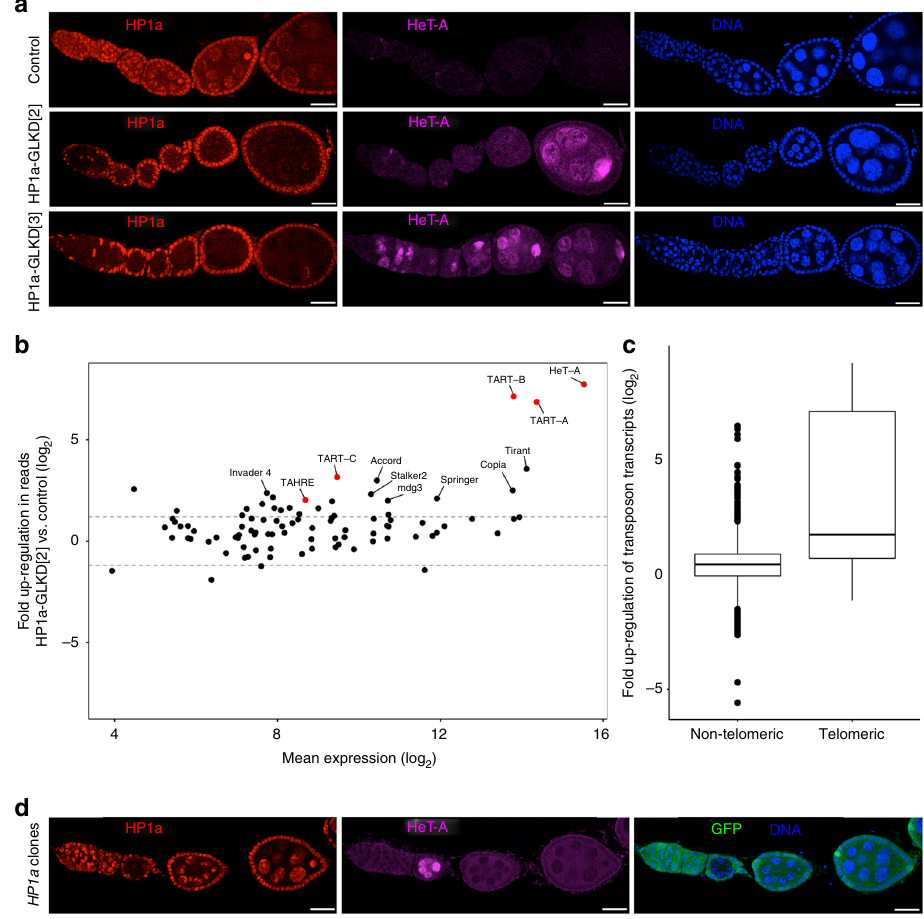
Fig. 1 HP1a is required for the repression of selective transposons. a Representative images showing control and HP1a-GLKD fl y ovaries stained for HP1a and HeT-A Gag proteins. Scale bars = 25 μ m; n > 5. b Scatterplot showing the fold up-regulation of normalised RNA-seq reads mapping to canonical transposons in HP1a-GLKD compared to control ovaries. Telomeric transposons HeT-A , TART , and TAHRE are labelled in red. c Boxplot representing fold up-regulation in normalised RNA-seq reads mapping to telomeric and non-telomeric transposons in HP1a-GLKD vs. control. The middle line represents median. Box represents 25 – 75 percentile range called inter quartile range (IQR). Upper and lower whisker extend highest or lowest values till 1.5*IQR. Values above and below are outliers and plotted individually. d Ovaries with an HP1a mitotic clone (arrowhead) generated by FRT/FLP recombination stained for HP1a, GFP, and HeT-A Gag proteins. HP1a-null cells recapitulate show HeT-A upregulation. Scale bars = 25 μ m; n =